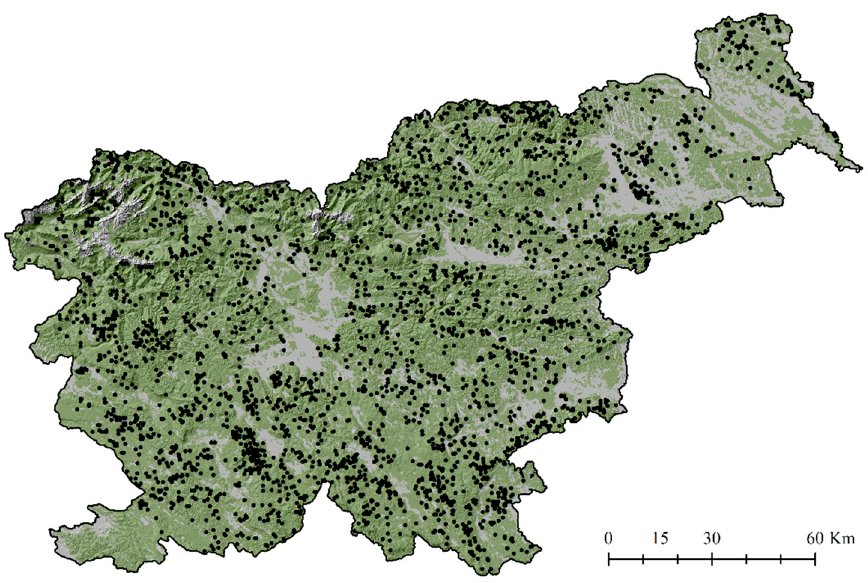
Figure 1. Forest distribution and grid of permanent sampling plots in Slovenia on which trees and regeneration (black dots) were inventoried ( n = 3366)